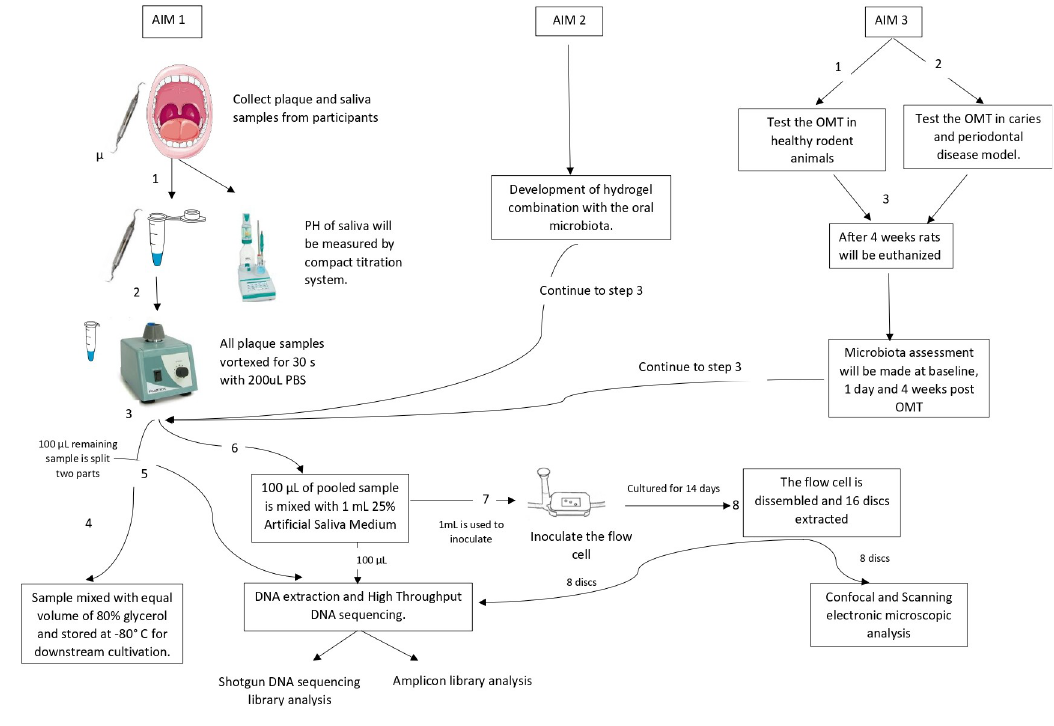
Fig 1. Study flow